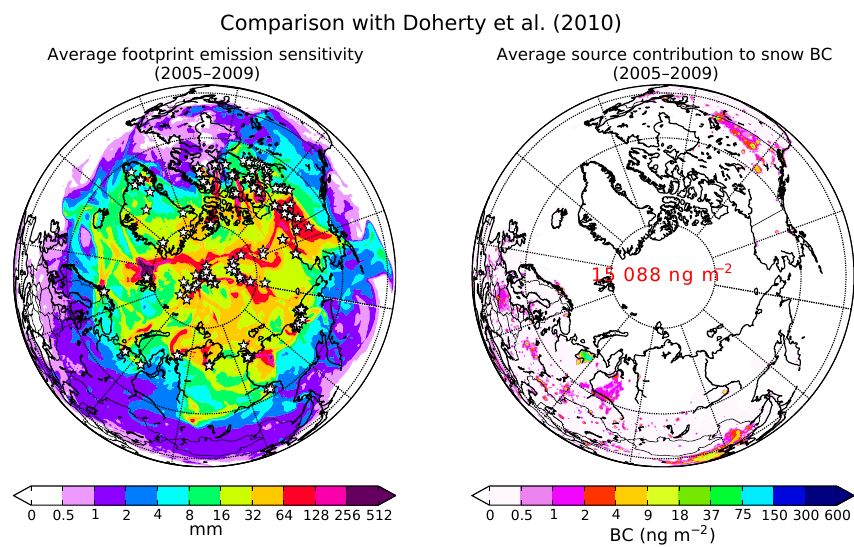
Figure 9. Average footprint emission sensitivity and source contribution for all samples shown in Fig.